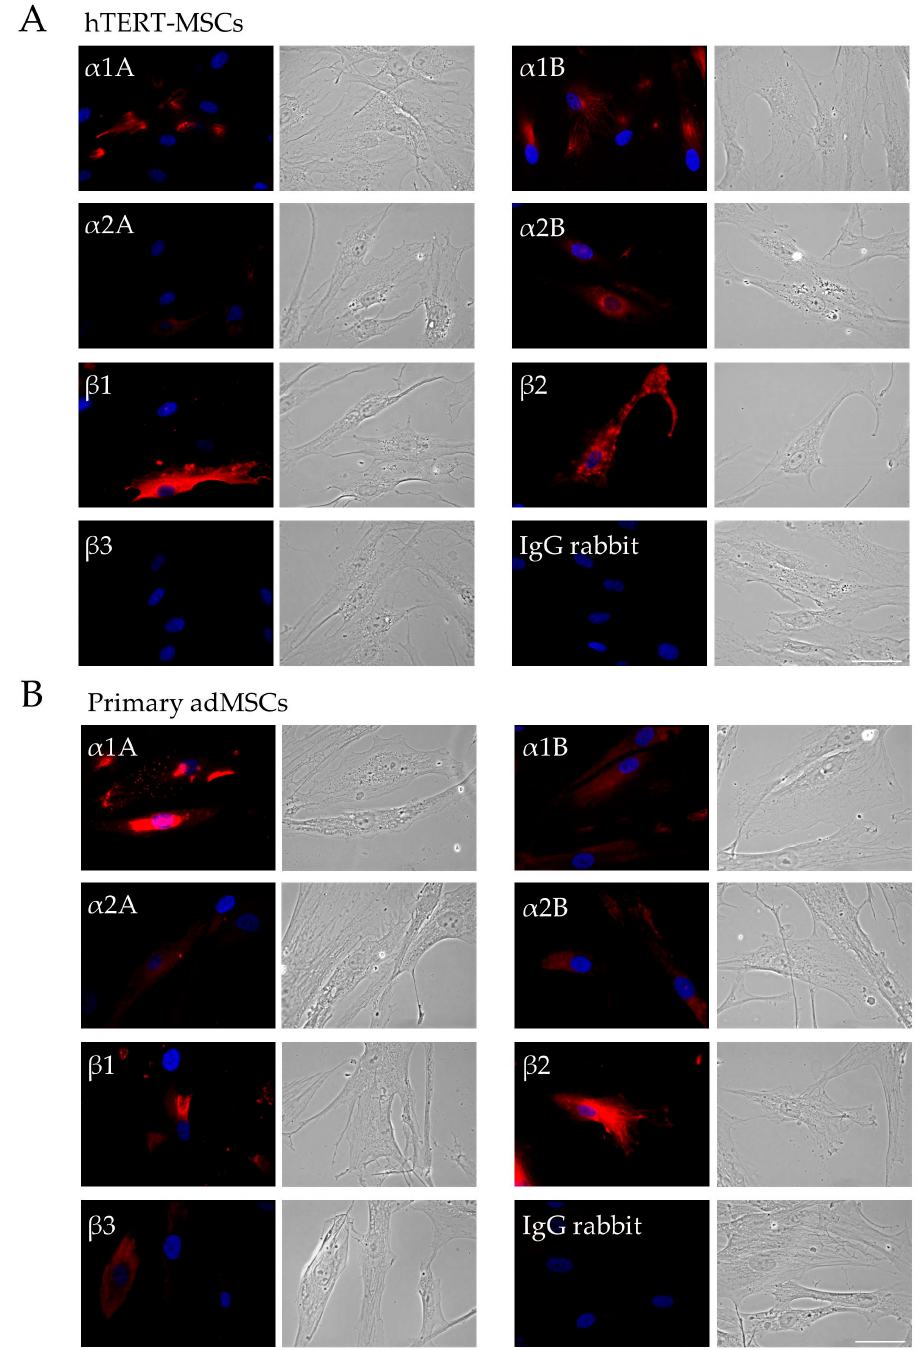
Figure 1. Immunofluorescent staining of adrenergic receptors in hTERT-MSCs ( A ) and primary adMSCs ( B ). Representative images of immunofluorescent staining of particular adrenergic receptors isoforms and corresponding bright field images. Receptor isoform name is marked in upper-left corner of each immunofluorescent image. Mouse IgG controls are the same as rabbit IgG and are not shown. Scale bar 50 μ m.